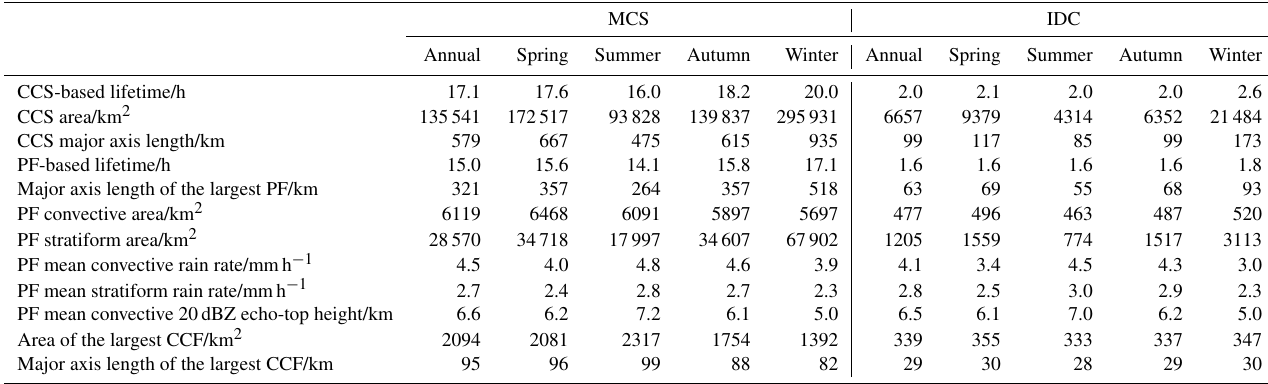
Table A5. Annual and seasonal mean characteristics of MCS and IDC events in the data product domain for 2004–2017 by using the new MCS definition ∗ .